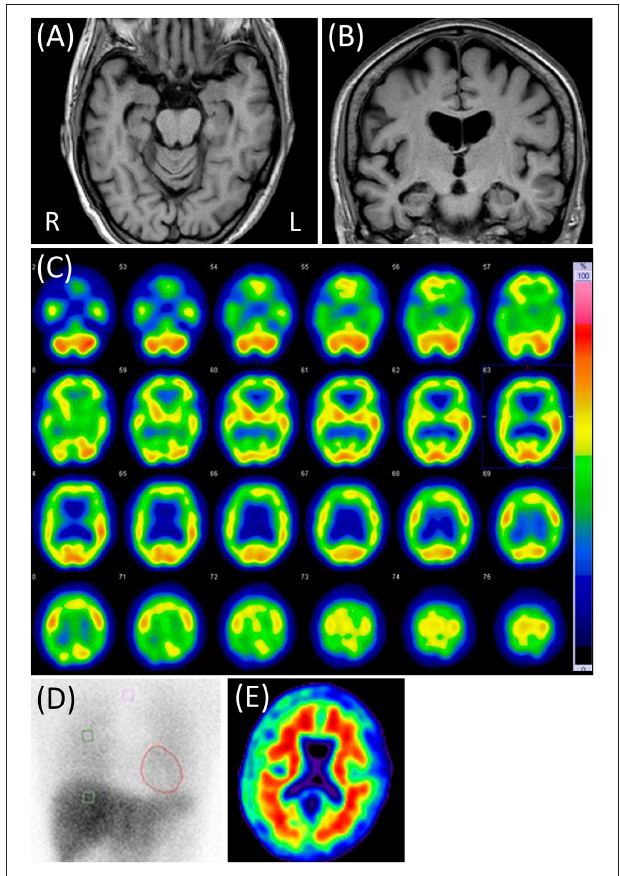
FIGURE 2 | Case 2 images. (A,B) Brain magnetic resonance T1-weighted images showing slight diffuse brain atrophy. (C) N-isopropyl-p-[123I] iodoamphetamine single-photon emission computed tomography showing right-dominant hypoperfusion in the bilateral frontal, parietal, and temporal lobes. (D) Cardiac [123I]-metaiodobenzylguanidine scintigraphy. Heart-to-mediastinum ratios were 3.90 and 4.28 in early and delayed phases, respectively. The washout ratio was 26.0%. (E) Negative Florbetapir 18 positron emission